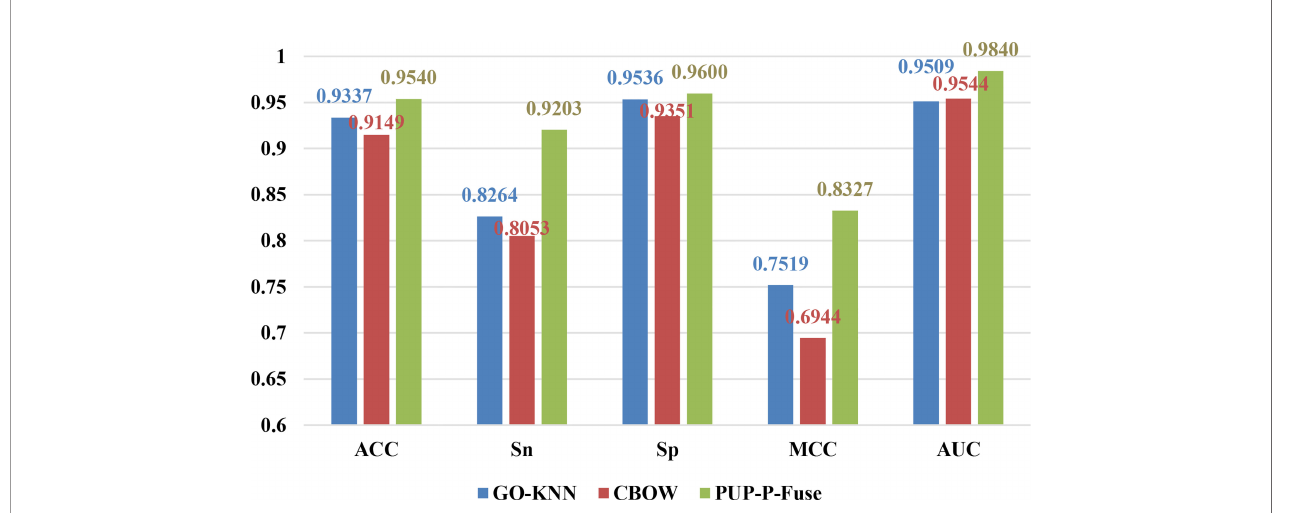
FIGURE 2 | The prediction results of different characteristics on balanced data for predicting pupylation proteins.